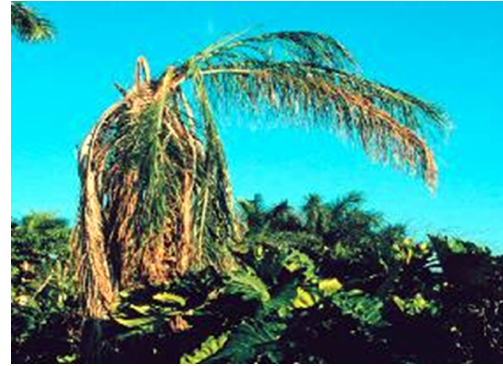
Fig. 1. Basal Stem Rot disease of the oil palm tree (Elliot et al .,